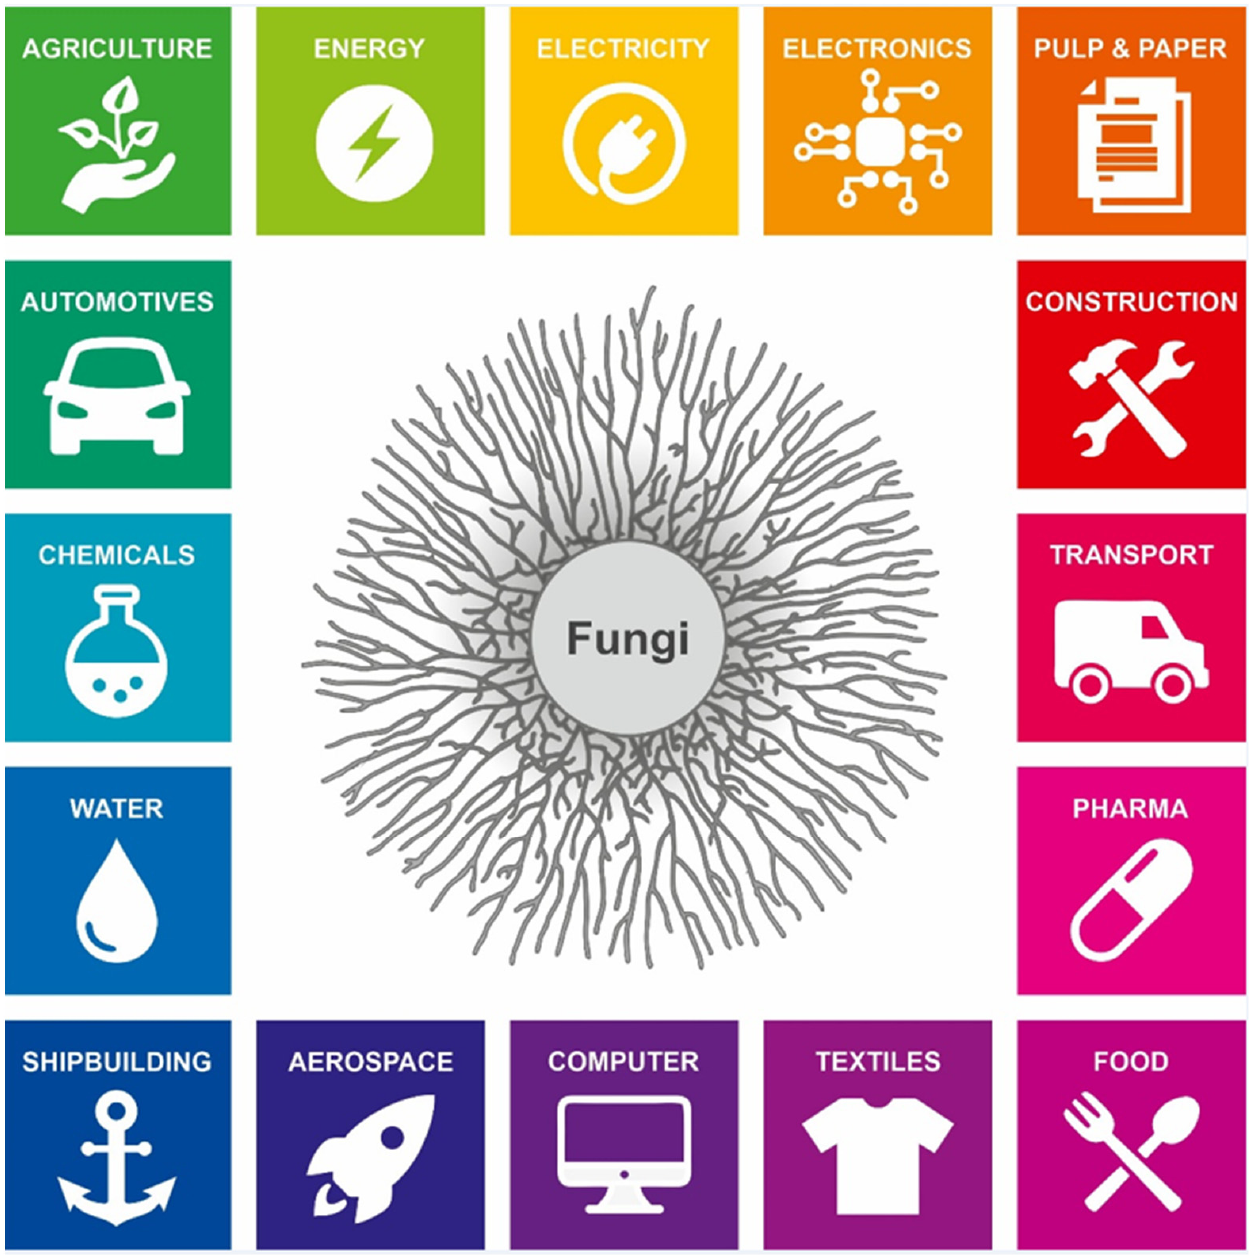
Figure 1. Industries utilizing the metabolic capacities of filamentous fungi. Reproduced from [6], CC BY 4.0.